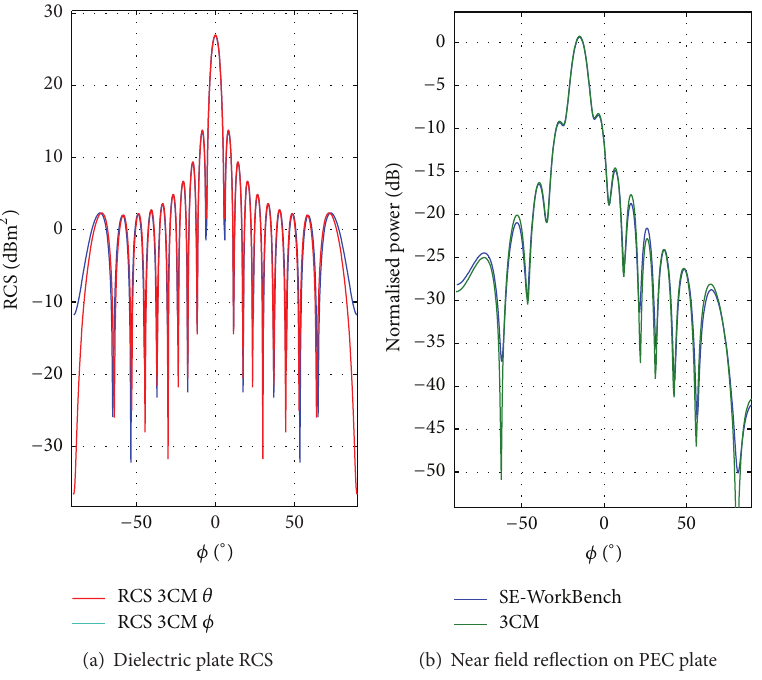
Figure 6: Validation examples of the implemented simplified PO algorithm for the specular component.